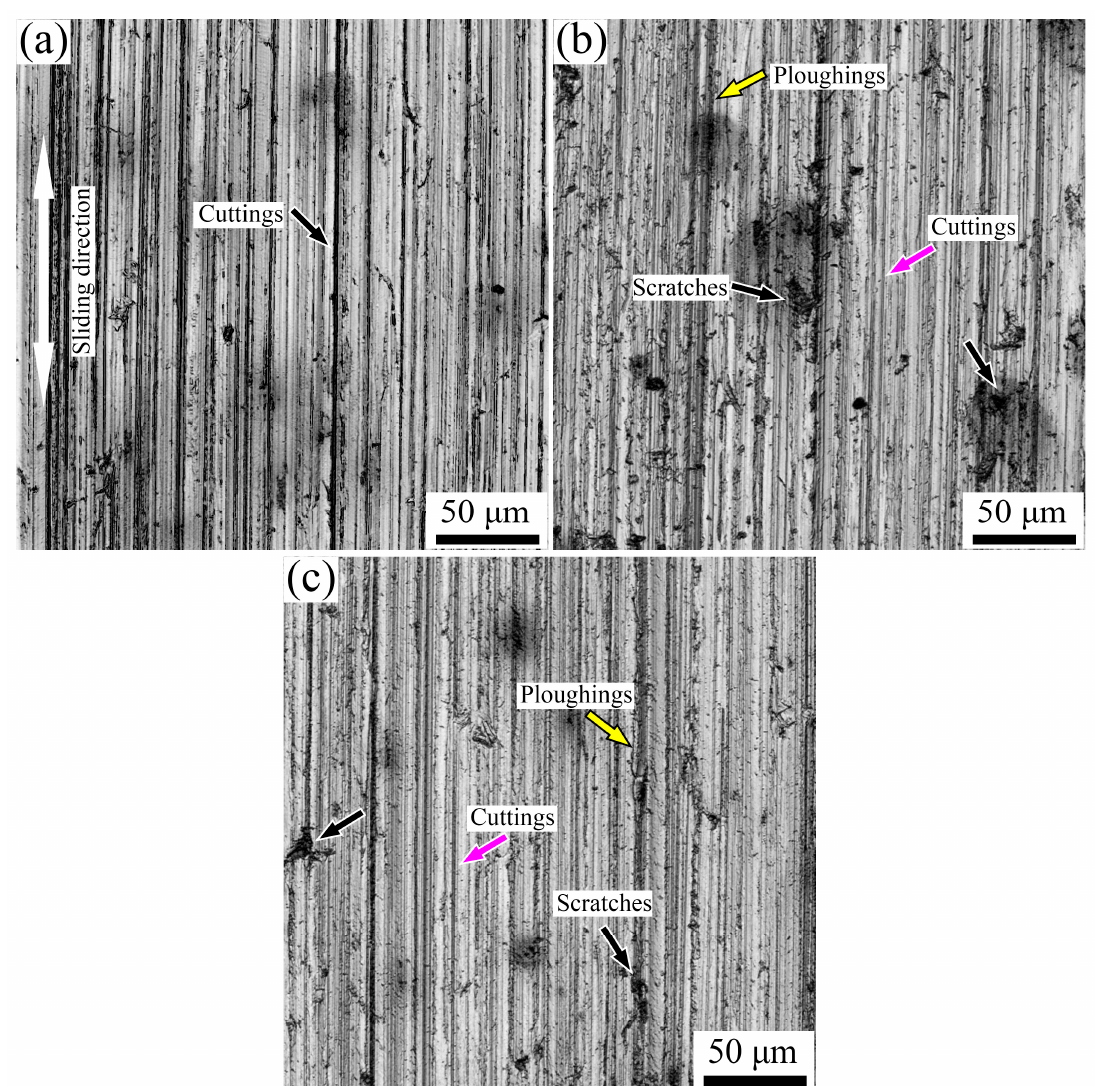
Figure 7. Worn surfaces of QT ( a ), NT ( b ), and ST ( c ) after abrasive tests. The depth of the grooves can be characterized by measuring the area roughness parameters as shown in Table 1. S q represents the root mean square value of ordinate values within the definition area. It is equivalent to the standard deviation of heights. S z is defined as the sum of the largest peak height value and the largest pit depth value within the defined area. S a is the extension of R a (arithmetical mean height of a line) to a surface. It expresses, as an absolute value, the difference in height of each point compared to the arithmetical mean of the surface. The smallest S q of QT indicates that the mean depth of the grooves in QT was the shallowest. The S z of NT was significantly greater than the S z of the other two, which indicates that the pits that appeared on NT were likely to be deeper